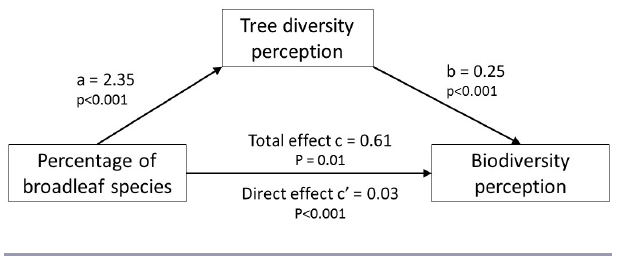
Fig. 2. Schematic diagram of mediation analysis results. Path a represents the effect of broadleaf species on tree diversity perception, path b represents the effect of tree diversity perception on the perception of biodiversity, and together they represent the indirect (mediated) effect of broadleaf species in biodiversity perception through the perception of tree diversity. Path c ′ represents the direct effect of broadleaf species on biodiversity perception when the indirect, mediated effect is controlled, and path c represents the total (mediated and direct) effect of broadleaf species on biodiversity perception. The requirements for a mediation effect are satisfied: paths a, b, and c are significant, and path c ′ is significantly smaller than path c, demonstrating that the perception of high tree diversity almost completely mediates the effect broadleaf species on users’ perception of